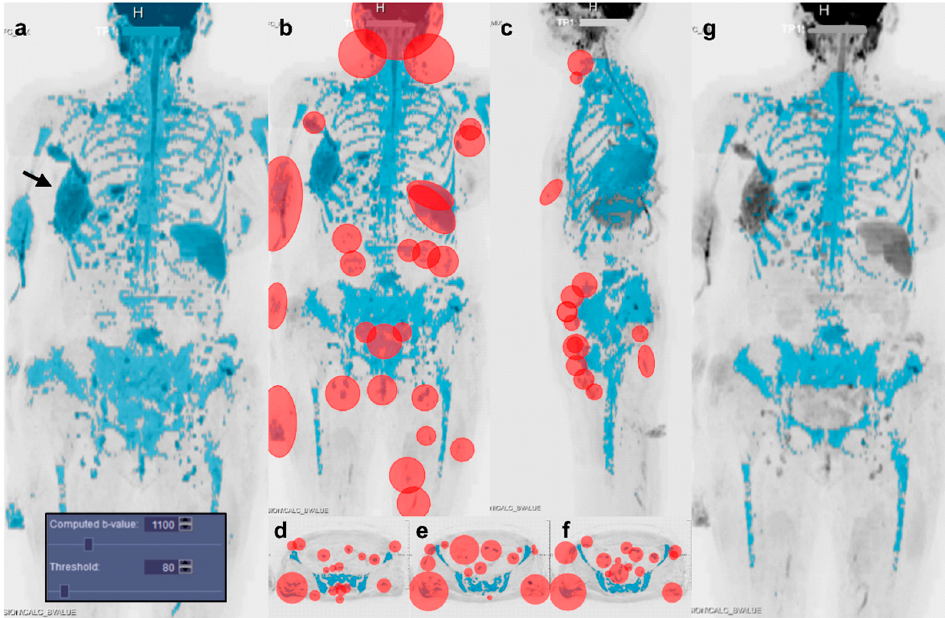
Figure 1. Illustration of the semi-automatic method used for bone marrow segmentation. Bone segmentation started with the observer interactively selecting a b -value for the calculation of a diffusion-weighted image stack (computed b -value) that provided good visual contrast between bone and surrounding tissues in coronal inverted gray-scale maximum intensity projection (MIP). ( a ) The observer then interactively adjusted a threshold to isolate voxels having high signal intensity on the computed b -value image (i.e., darker on the inverted MIP) to incorporate as much bone as possible in the resulting mask (seen overlaid in blue on the inverted MIP of the computed b -value DWI stack). The initial mask thus included suspected hypercellular lesions and as much bone as possible, but inevitably also included some non-bone tissues, typically brain and spinal cord, spleen, male gonads, breast implants, and sites of soft tissue inflammation or soft tissue lesions (e.g., the large soft tissue metastases along the right chest wall (arrow) and supraclavicular lymph nodes seen in this case of a 71-year-old woman with operated lobular carcinoma of the right breast, undergoing endocrine treatment). Manual editing was therefore performed to remove as much non-bone tissue as possible using a combination of: ( b ) full-depth cutting of ellipsoids (overlaid in red) positioned on the coronal MIP to eliminate brain, neck lymph nodes, soft tissues of the small pelvis, and as needed, spleen, kidneys, and lymph nodes not overlapping diseased bone, followed by ( c ) full-depth cutting of ellipsoids (overlaid in red) drawn on the sagittal MIP to eliminate soft tissues of the anterior neck, breast implants (if any), bowel, rectum, as well as inguinal and external iliac lymph nodes. If needed, ( d , e , f ) single-slice cutting of ellipsoids (overlaid in red) on individual axial, coronal or sagittal slices to eliminate soft tissues that projected over bone in the MIPs. Finally, the bone mask ( g ) was saved as a DICOM image